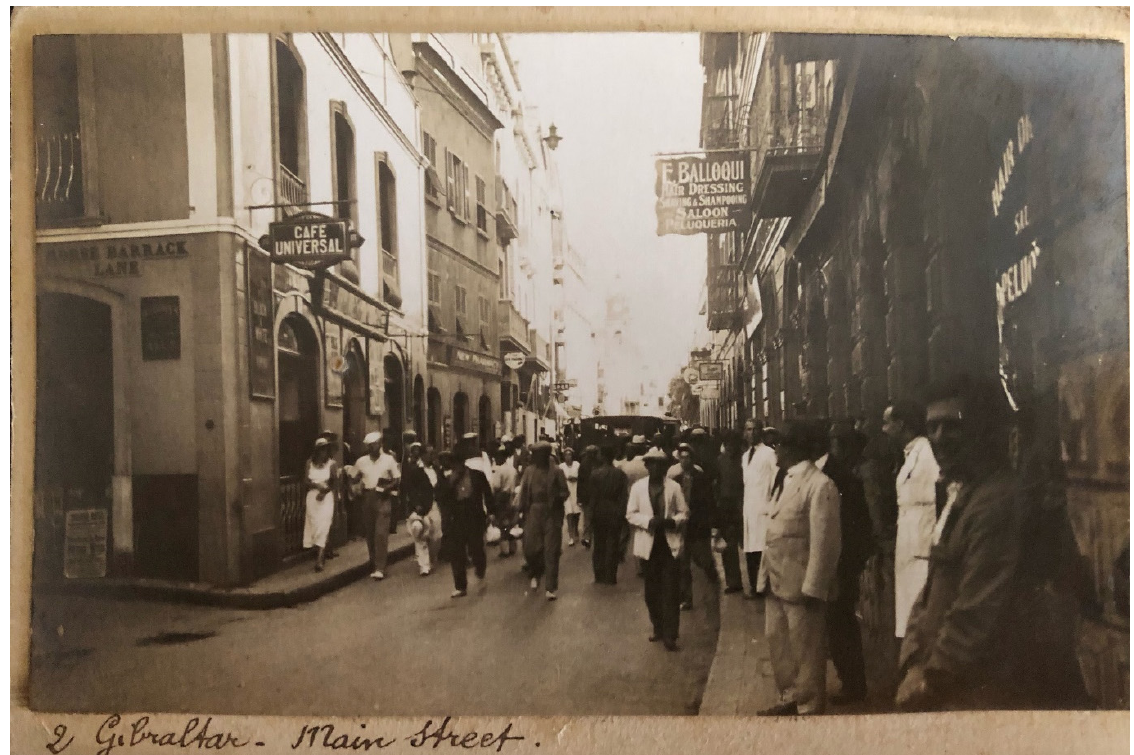
Figure 7. Early twentieth-century prototype photo-postcard showing the Café Universal (site of la Vera Cruz church).